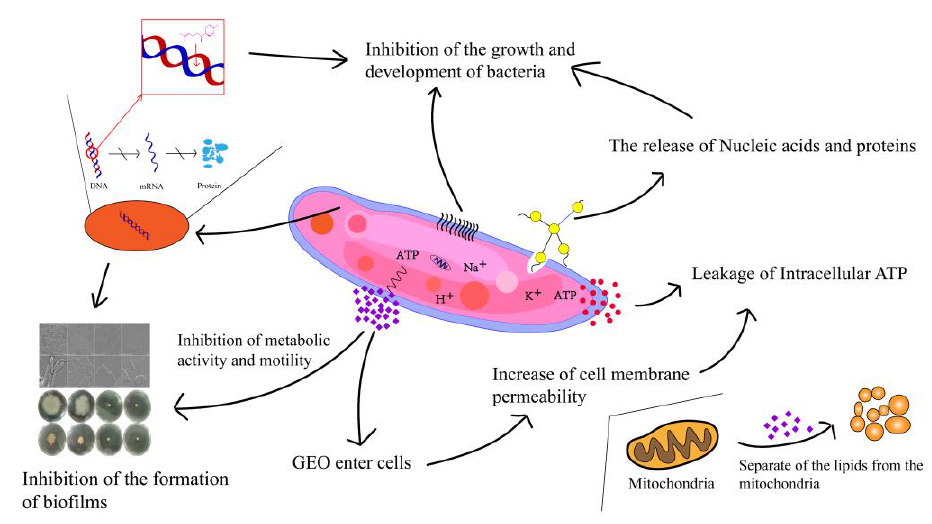
Figure 7. The antibacterial and antibiofilm mechanism of GEO.